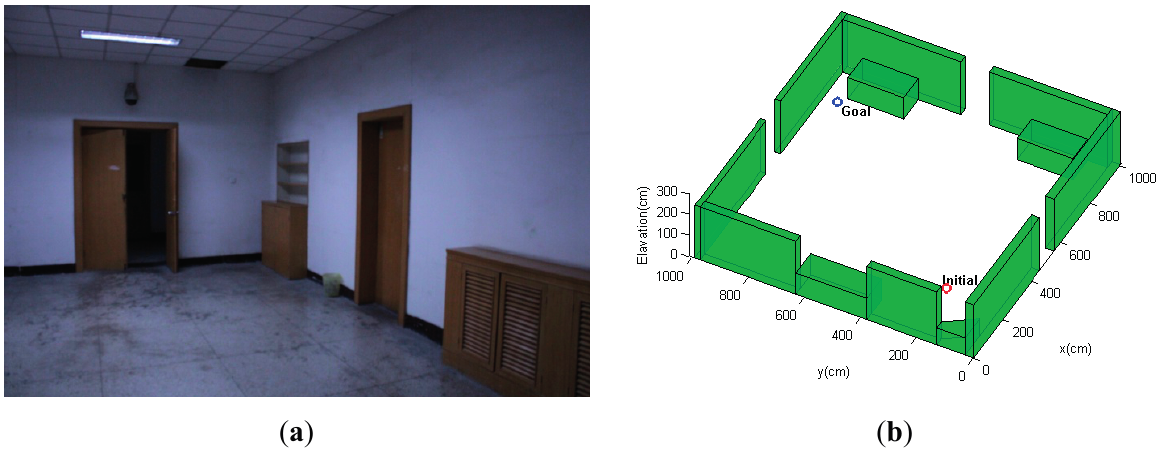
Figure 7. Indoor environment simulation Scenario 1: ( a ) A hallway of Tsinghua University’s main building; ( b ) simulated 3D model of the GPS-denied indoor environment. The red and blue circles indicate the initial and goal location of the MAV,